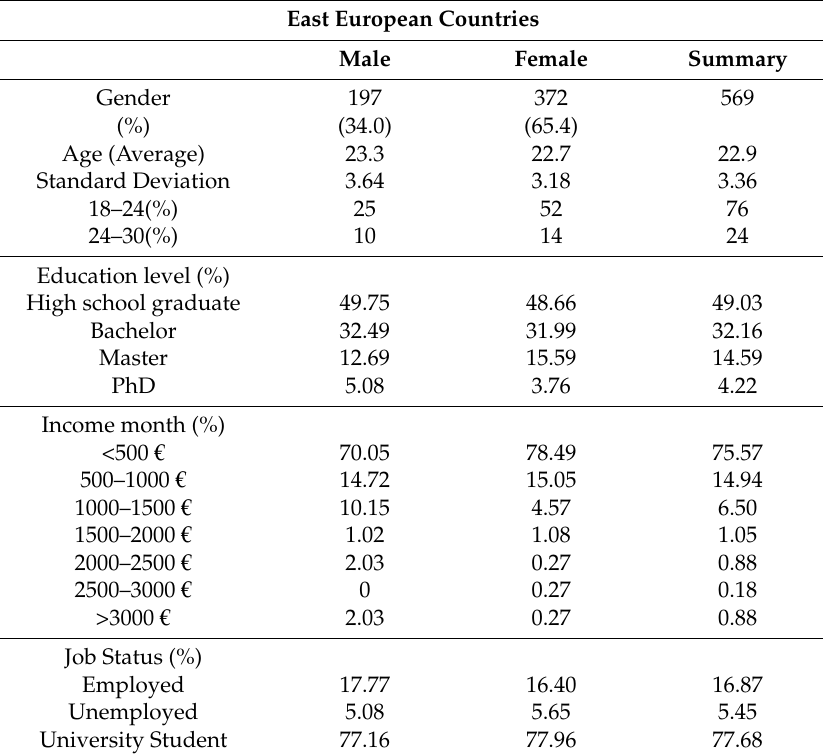
Table 2. Subset 1 sample ( n =